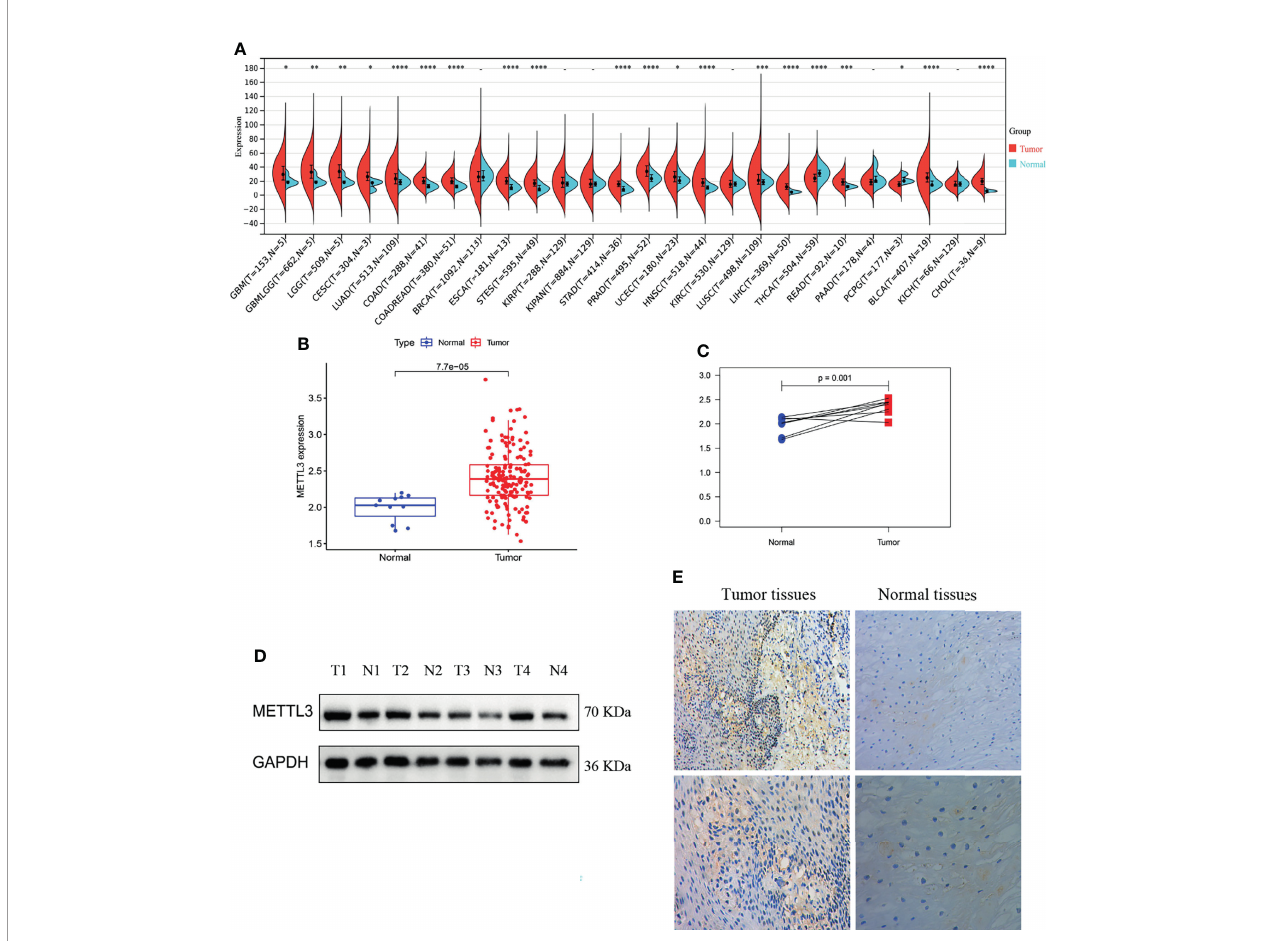
FIGURE 1 | METTL3 was overexpressed in tumor tissues. (A – C) Differential expression of METTL3 between tumor tissues and normal tissues (the normal tissue is represented by blue, whereas the tumor tissue is shown in red; * P < 0.05, ** P < 0.01, *** P < 0.001 and **** P < 0.0001. -, not signi fi cant). (D, E) Immunohistochemical staining and western blotting of ESCC tissues (n = 4) and adjacent tissues (n =